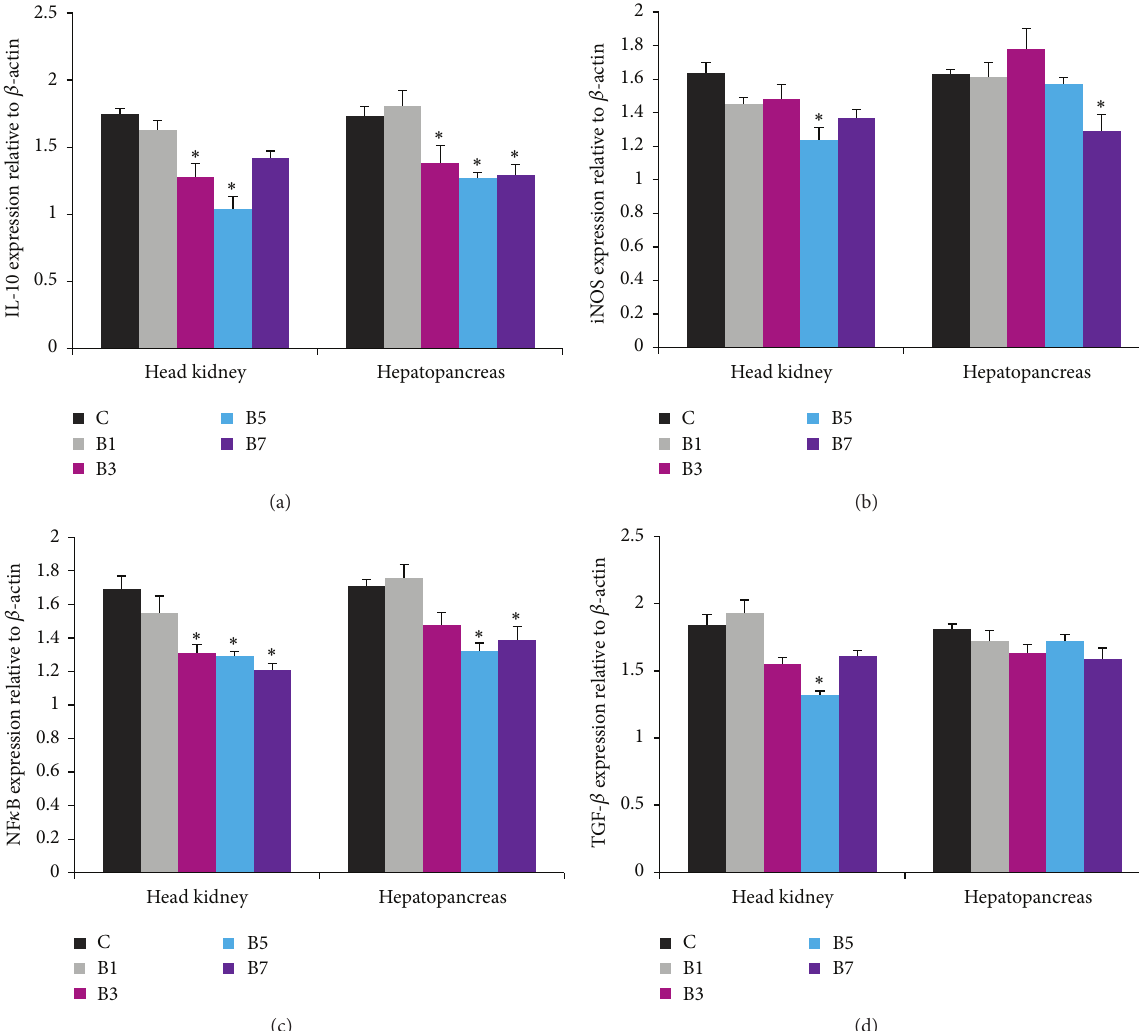
Figure 2: Relative mRNA expressions of IL-10 , iNOS , NF- 𝜅 B , and TGF- 𝛽 in the head kidney and hepatopancreas of Labeo rohita fed banana peel flour (BPF) supplemented diets. A significant difference is denoted by an asterisk ( 𝑃 < 0.05 ). Each bar represents mean ± SEM ( 𝑛 = 9 ).